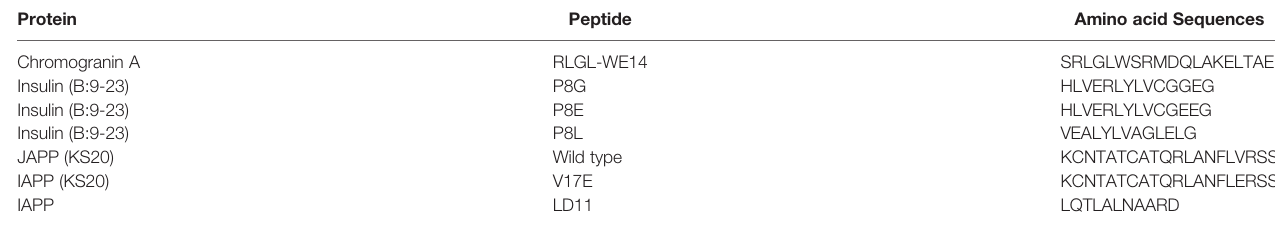
TABLE 1 | The peptides used in studies. Protein Peptide Chromogranin